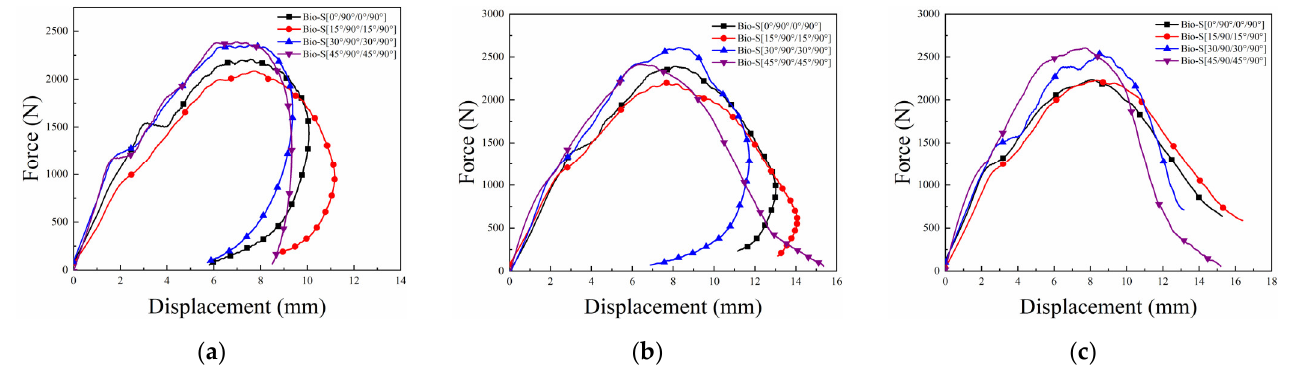
Figure 12. Force-displacement curves of the Bio-S composite plates with different angles of first-third layers configurations under different impact energy levels: ( a ) 15 J; ( b ) 20 J; ( c ) 25 J.